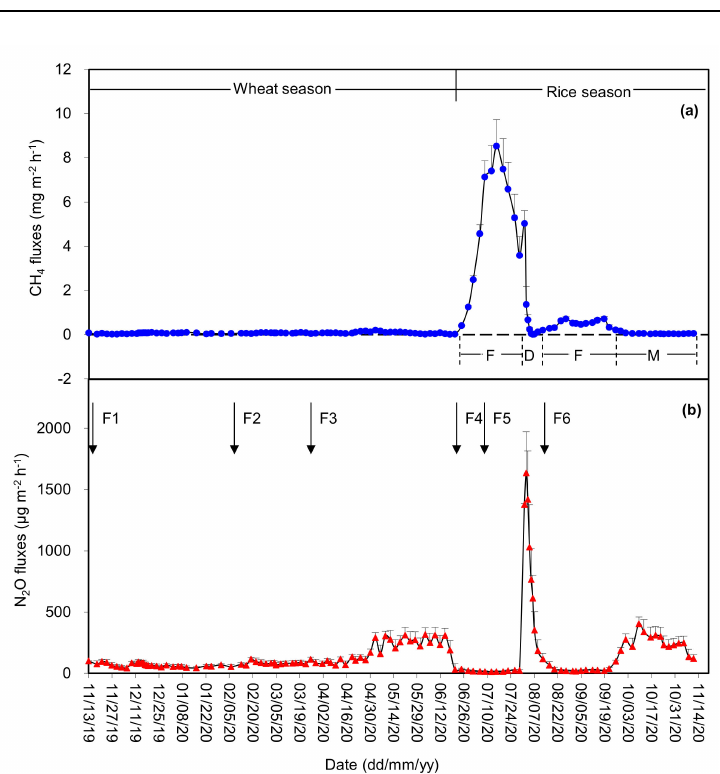
Figure 1. Annual dynamics of CH 4 ( a ) and N 2 O ( b ) fluxes from rice − wheat rotation. F − initial flooding; D − midseason drainage; M − moisture irrigation without waterlogging. F1–F6 solid arrows indicate N fertilizer application events. The bars indicate the standard error of the means ( ±